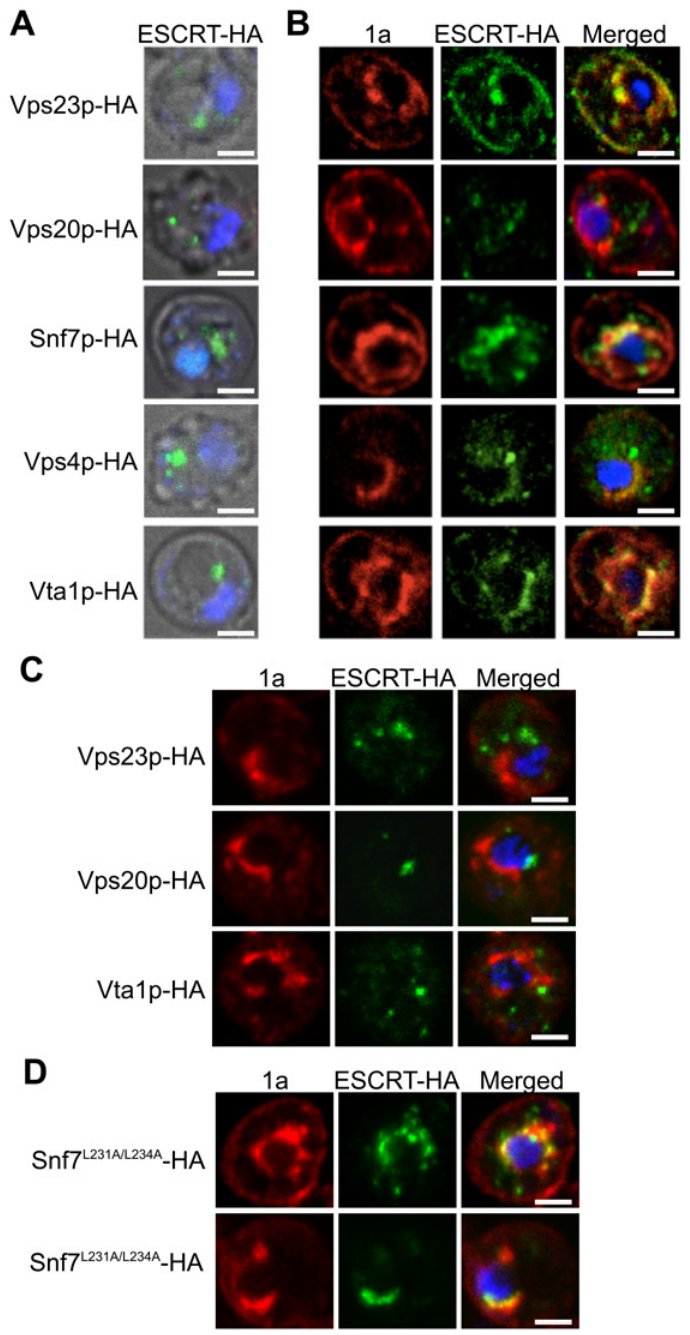
Fig 3. Snf7p relocalizes with other ESCRT components to the site of BMV RNA replication. Localization of HA-tagged ESCRT proteins expressed from their endogenous promoters in vps4 Δ yeast transformed with (A) empty plasmids or (B) 1a. Yeast were immunostained for the HA-tagged ESCRT proteins (green) and BMV 1a (red) while DNA was stained with DAPI (blue). Images were cropped just outside the yeast cell wall to include only one cell. Scale bars: 2 μ m. (C) Localization of HA-tagged ESCRT proteins in snf7 Δ yeast transformed with BMV 1a and Vps4 E233Q -FLAG. Scale bars: 2 μ m. (D) Localization of HA-tagged Snf7 L231/L234 proteins in snf7 Δ yeast transformed with BMV 1a and Vps4 E233Q -FLAG. Scale bars: 2 μ m.